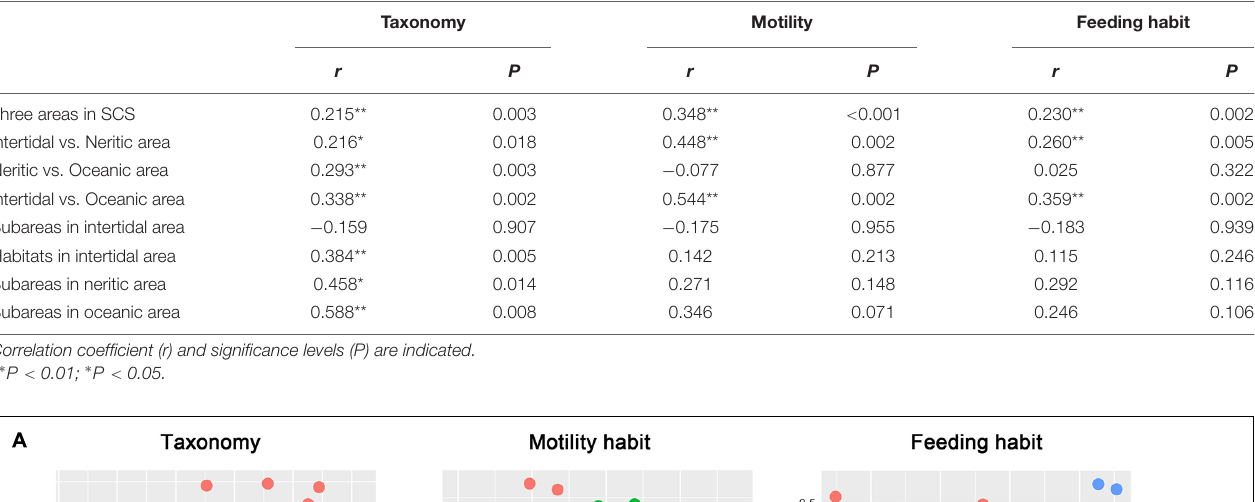
TABLE 1 | Analysis of similarities (ANOSIM) of ciliate communities among groupings.